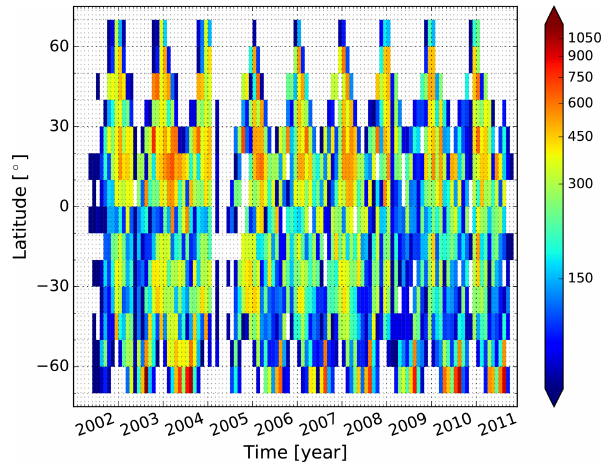
Figure 3. Monthly averaged spectrum from GOMOS (black solid line) for February 2004 at 40–50 ◦ N and at a tangent altitude of 89.5km. Strong emission lines from the OH(8–4) band are anno- tated with the branch and rotational quantum numbers. The wave- length range from 930 to 935nm is selected and used in the re- trieval. The corresponding SCIAMACHY data (red dashed line) are also given here for